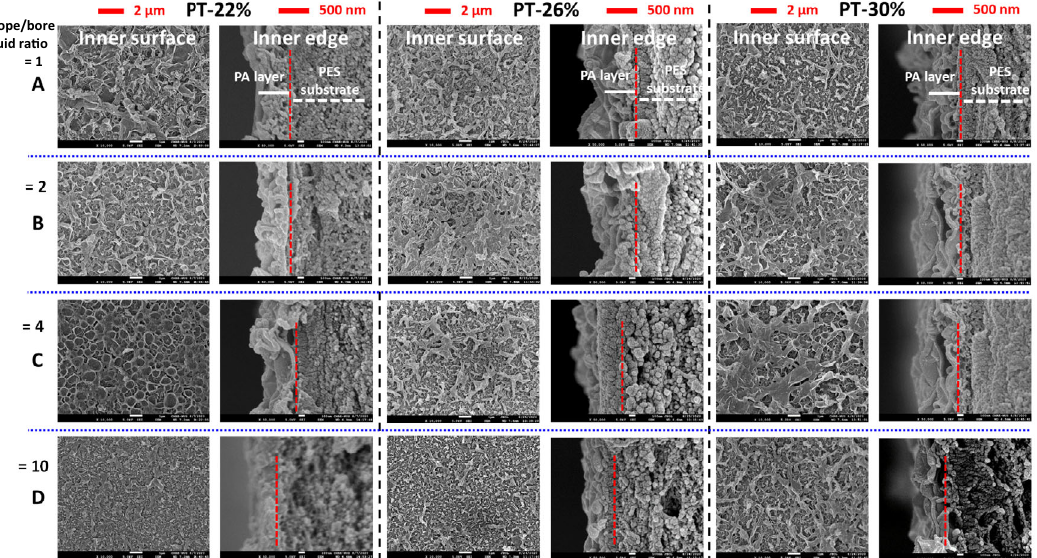
Fig. 5 FESEM morphologies of the inner surface and inner edge of the cross-section of PES-TFC hollow fi ber membranes. Polyamide (PA) layer was denoted as PA